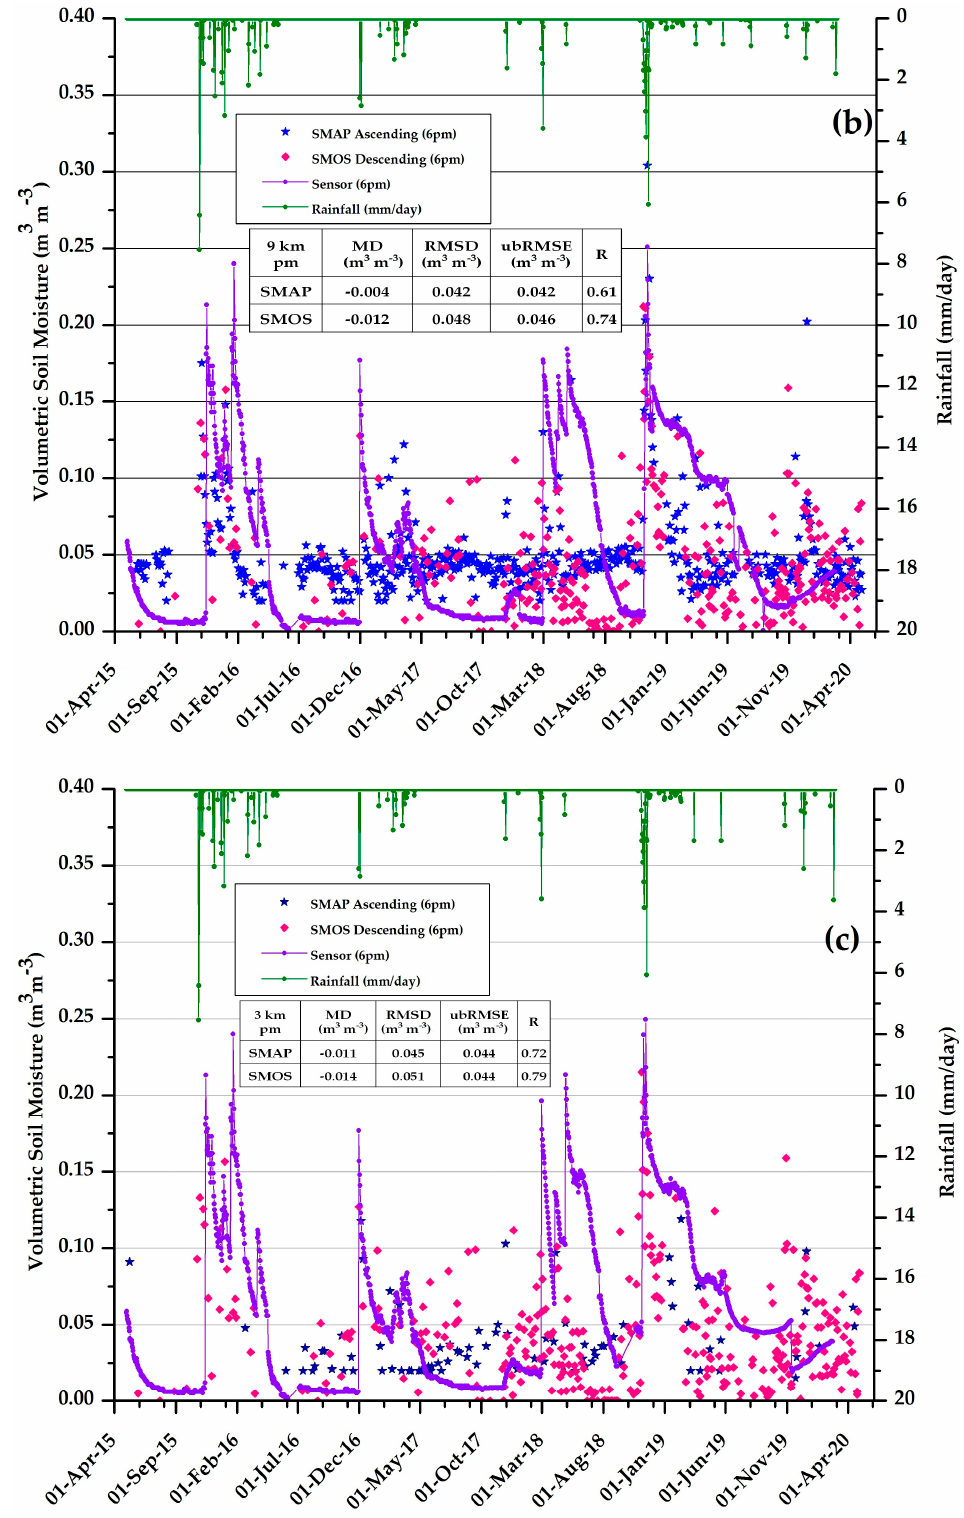
Figure 9. Validation of VSM from SMAP and SMOS 6 pm overpass using ground station sensors and rainfall records at ( a ) 36 km, ( b ) 9 km, and ( c ) 3 km.